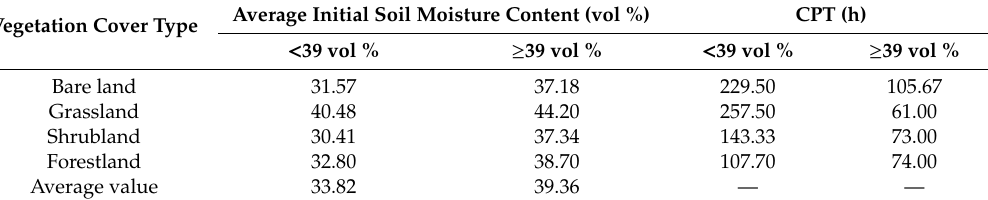
Table 6. A comparison of peak volumetric soil moisture times of the di ff erent vegetation types when the average initial volumetric soil moisture content is larger than the cumulative peak time (CPT; i.e., 39) and smaller than the CPT (i.e., < 39). ≥